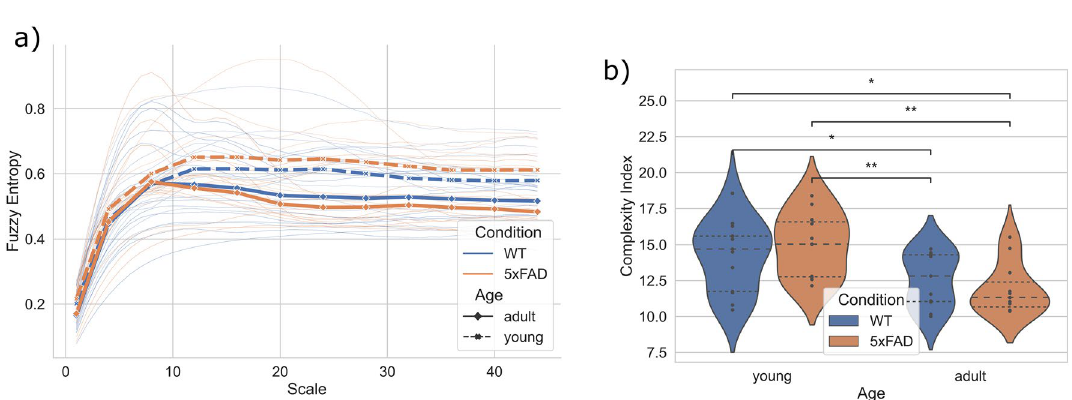
Figure 3. Time- and frequency-domain characteristics of µ ERG responses during the natural image (NI) protocol. ( a ) µ ERG responses during the NI protocol for all retinas separated by condition and age. ( b ) Average power spectral density (PSD) of the µ ERG responses. ( c ) Average signal and standard deviation of µ ERG responses. Shaded areas indicate 95% confidence intervals.